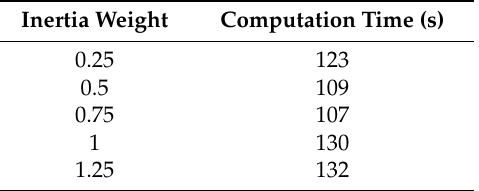
Figure 9. Convergence with different inertia weights. Table 2. Computation time with different inertia